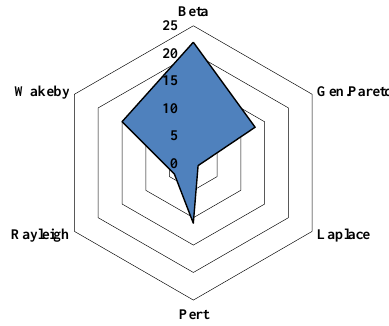
RayleighWakeby Figure 4. Statistics of the probability distribution function of precipitation sequence of summer maize at 66 sites. Figure 4. Statistics of the probability distribution function of precipitation sequence of summer maize at 66 sites. Figure 4. Statistics of the probability distribution function of precipitation sequence of summer maize at 66 Figure 4. Statistics of the probability distribution function of precipitation sequence of summer maize at 66 sites. at 66 sites.